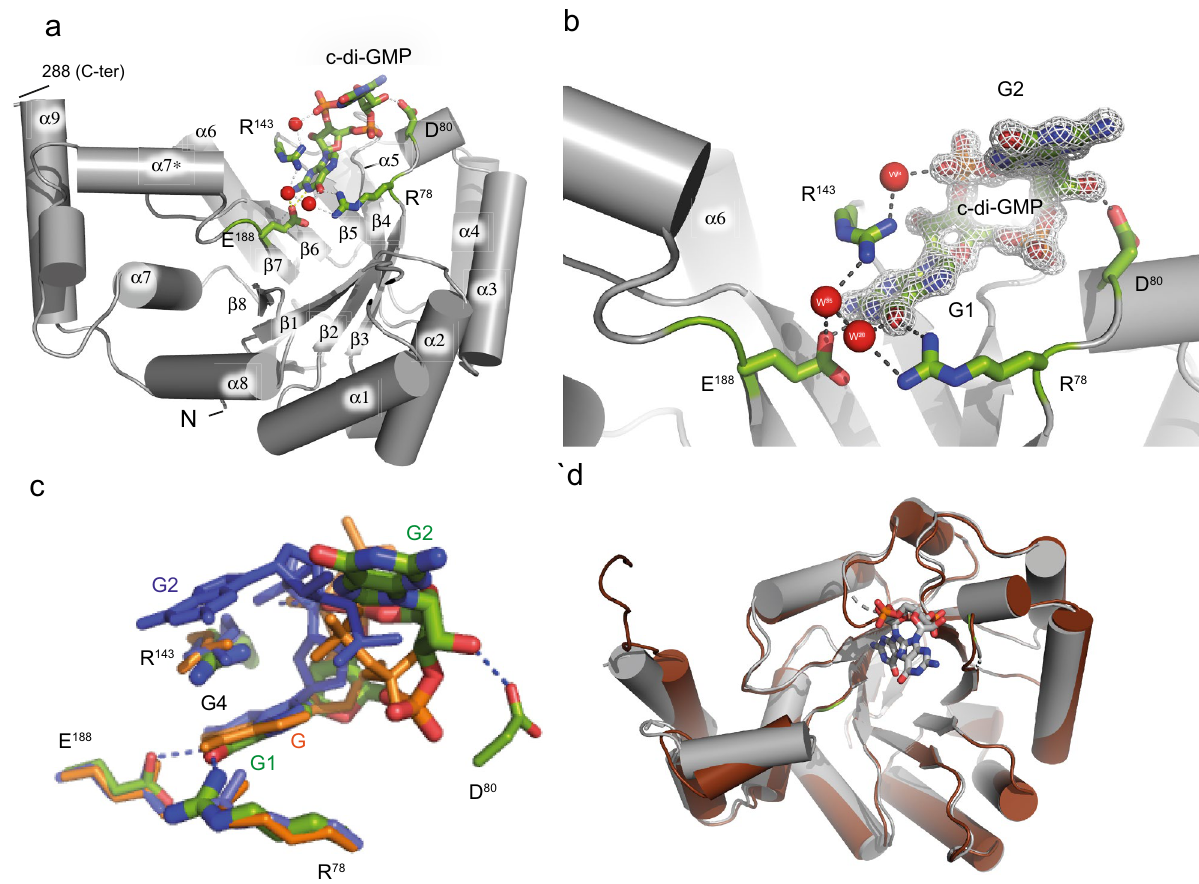
Figure 3. Detailled crystal structures of SmbA Δloop in presence and absence of c-di-GMP and and structural comparison with wild-type SmbA ligands. ( a ) Crystal structure of the SmbA Δloop with the backbone drawn in grey cartoon and monomeric c-di-GMP shown in a stick. Residues in the SmbA Δloop important in interaction with the c-di-GMP molecule are drawn in stick representation. Carbon atoms are shown in green, nitrogen in blue and oxygen in red. ( b ) 2Fo-Fc omit maps contoured at 1.2 σ of c-di-GMP and full structural details of the interacting residues. H-bonds (length < 3.5 Å) are indicated by gray lines and water molecules in red spheres. ( c ) View of c-di-GMP (green) as bound to SmbA Δloop , and the proximal c-di-GMP molecule (blue) of dimeric c-di-GMP and ppGpp (orange) as bound to wild-type SmbA. The proximal guanyl of monomeric c-di-GMP (G1), guanyl of ppGpp (G) and G4 of dimeric c-di-GMP overlap closely. While the other guanyl (G2) of the monomeric ligand has moved out considerably, to form isologous interactions with the second SmbA Δloop molecule (not shown). ( d ) structural superposition of SmbA Δloop /c-di-GMP (gray) with SmbA Δloop (chocolate) yielding a RMSD of 0.49